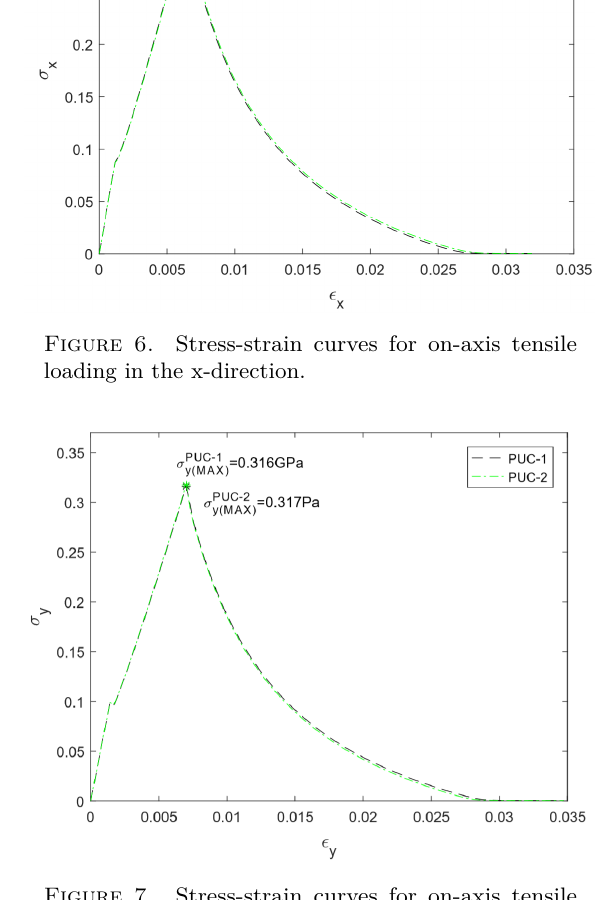
Figure 7. Stress-strain curves for on-axis tensile loading in the y-direction.